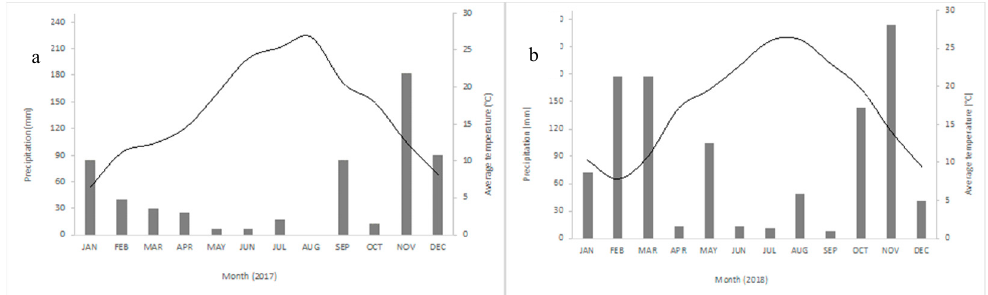
Figure 3. Temperature (line) and precipitation (bars) in the experimental area in year 2017 ( a ) and 2018 ( b ).